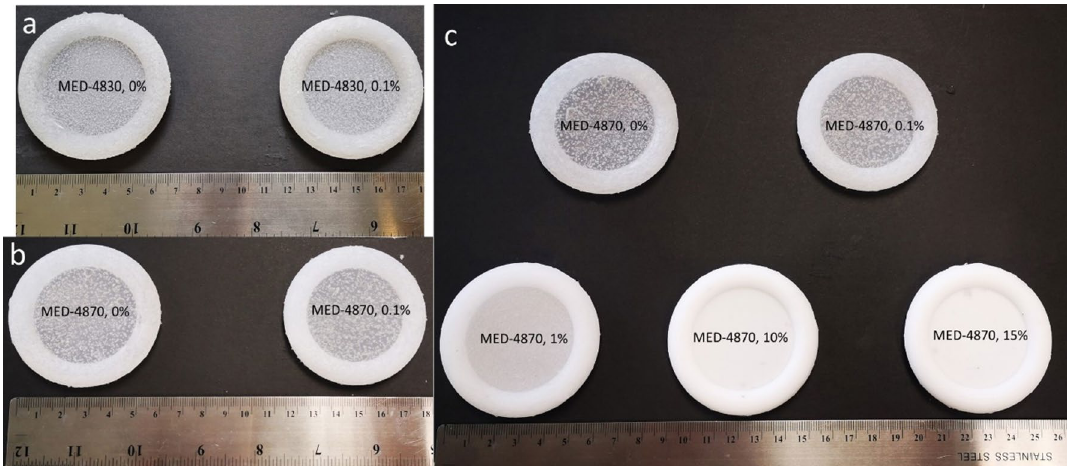
Figure 2. Manufacture trial ( a ) and ( b ) and improved trial ( c ) of silicone rings with different drug contents. Silicone and estriol loading